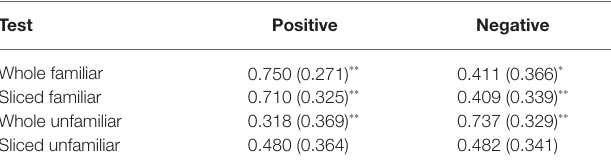
TABLE 4 | Mean probability to generalize positive and negative properties (SD in brackets).